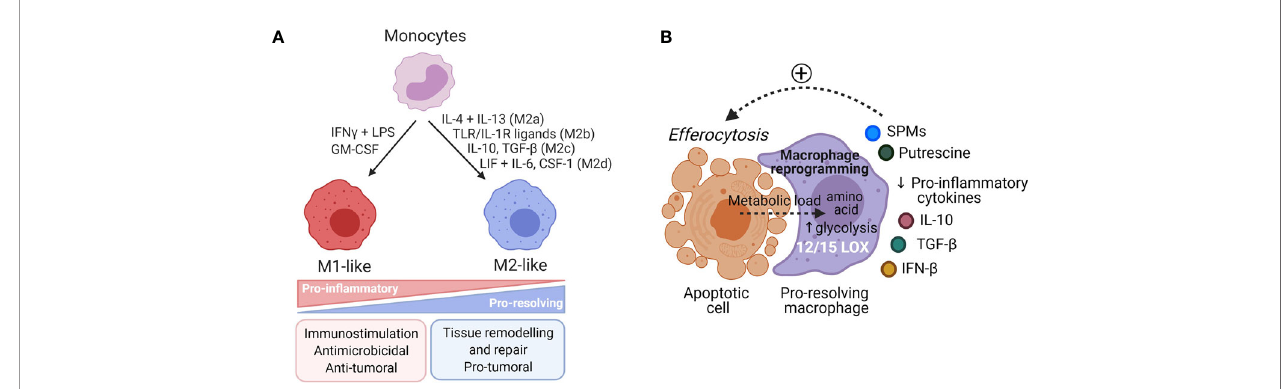
FIGURE 2 | Diversity of macrophages ’ phenotypes. (A) Monocytes can be differentiated in vitro either in pro-in fl ammatory M1-like macrophages or in anti- in fl ammatory M2-like macrophages upon various external stimuli. M1-like macrophages are involved in microbicidal and tumoricidal activities. M2-like macrophages have pro-resolving functions and are involved in tissue repair. In cancer settings, TAM, associated to a M2-like phenotype, support tumor progression and mitigate tumor response to anticancer treatments through production of proteases, angiogenic and growth factors. (B) During efferocytosis of apoptotic cells, macrophages undergo a reprogramming toward a pro-resolving phenotype. Macrophages receive an important metabolic load from these engulfed cells that induce metabolic modi fi cations such as activation of the putrescine pathway or increased glycolysis that supports actin polymerization and cell clearance. Pro-resolving macrophages express 12/15-LOX and turn off production of pro-in fl ammatory cytokines for production of IL-10, TGF- b and IFN- b that participate in in fl ammation